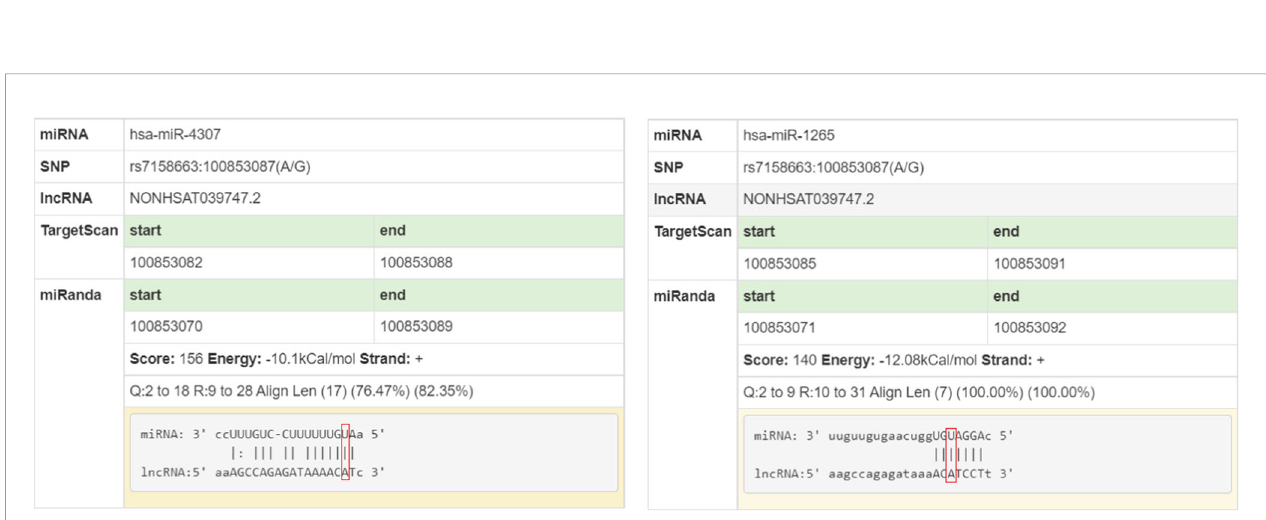
FIGURE 2 | lncRNASNP-based analysis of the effect of rs7158663 polymorphism on miRNA binding.